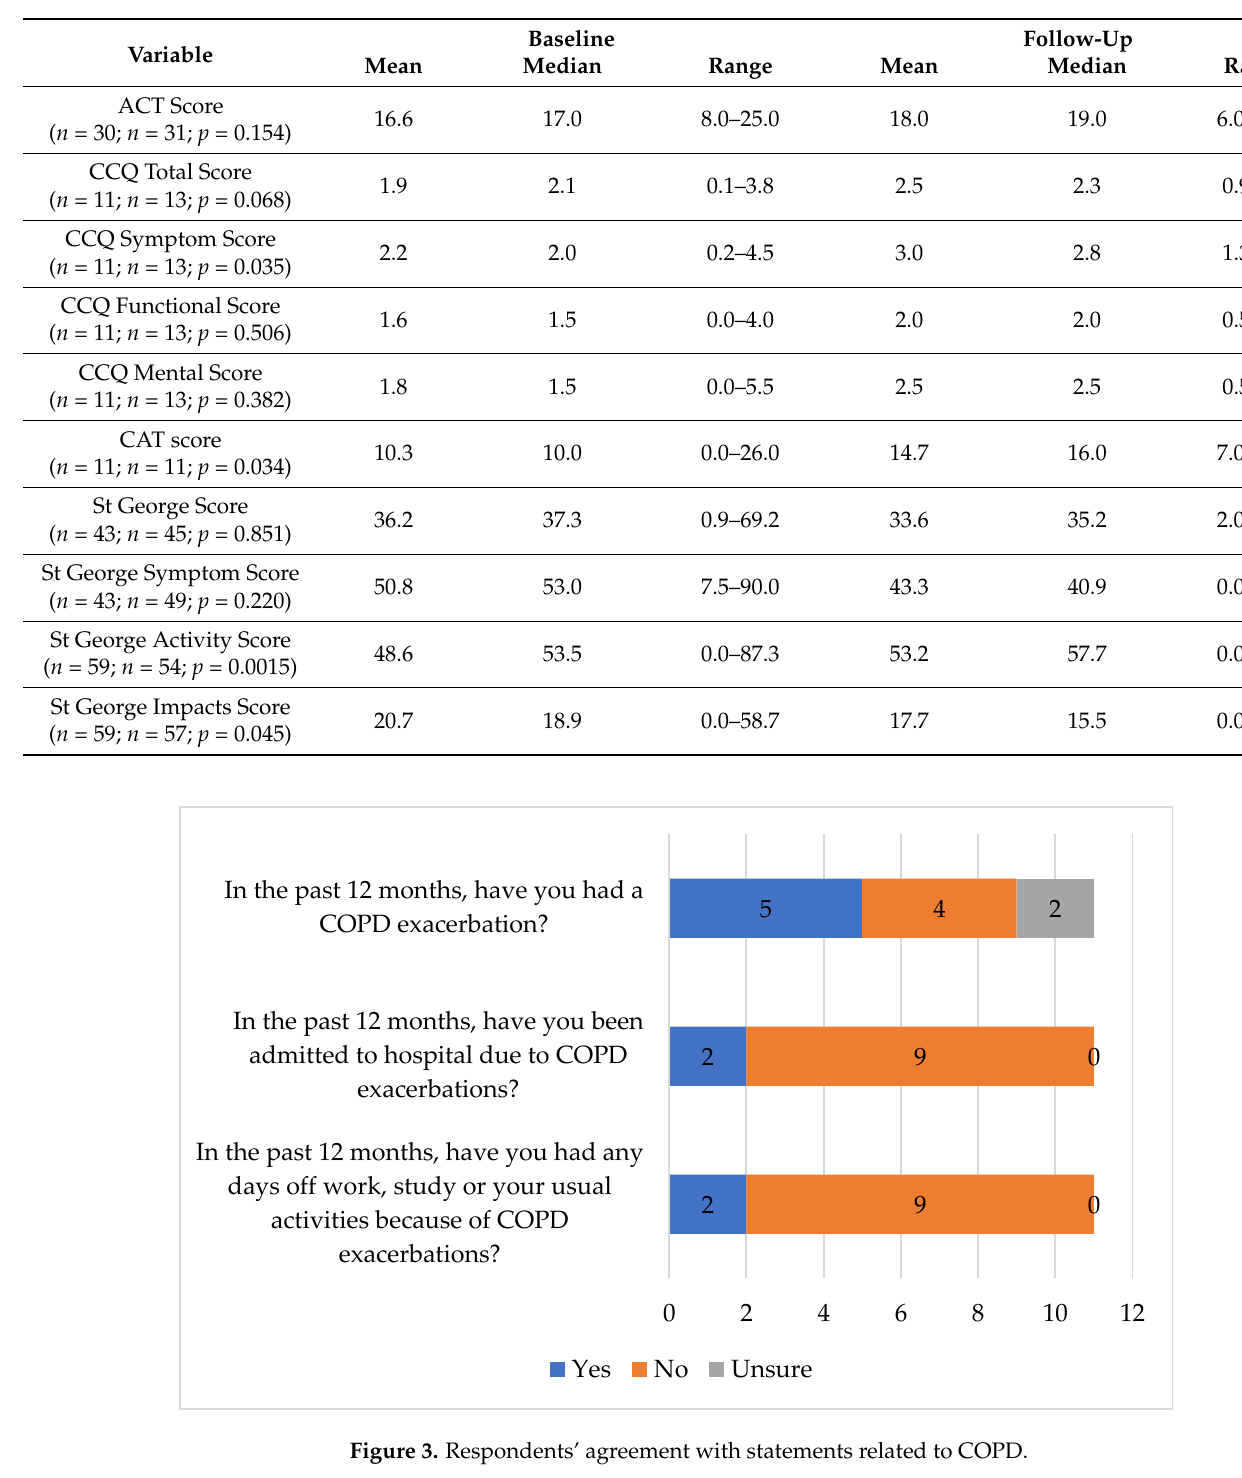
Table 4. Differences in various validated test scores at baseline and follow-up between metropolitan and rural areas.